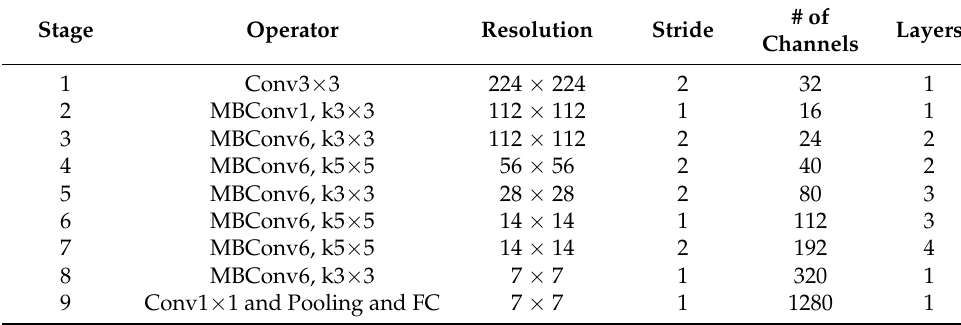
Table 2. EfficientNet-B0 architecture [11].